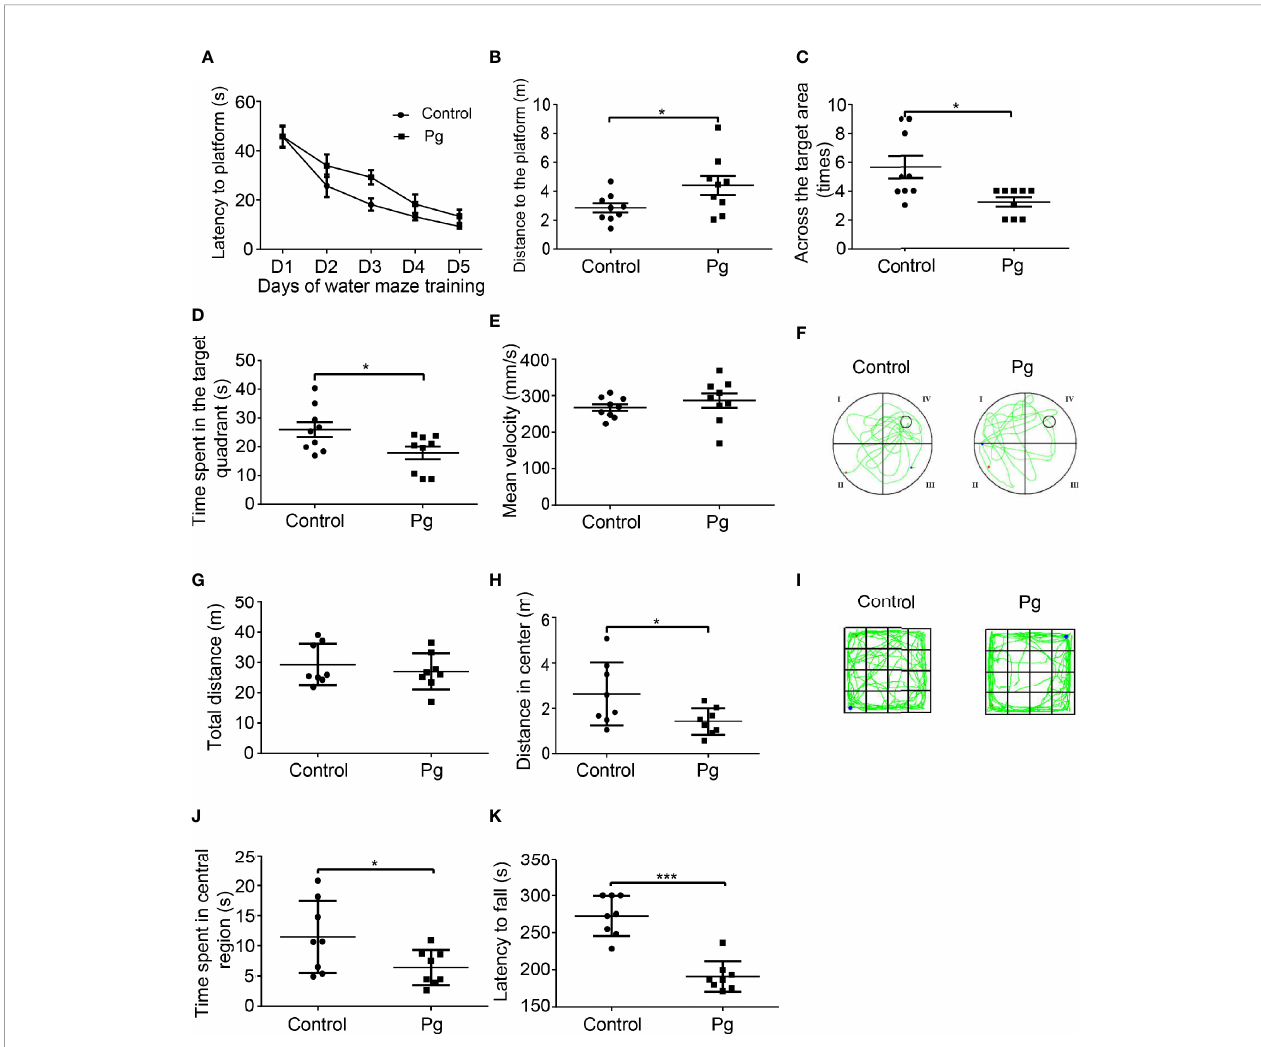
FIGURE 1 | The effects of Porphyromonas gingivalis (Pg) on behavioral changes of mice. (A) Escape latencies in spatial acquisition trial of the Morris water maze (MWM). (B) The distance of mice to locate the platform on day 5. (C) The number of times the platform was crossed in the probe trial of the MWM. (D) Target quadrant movement time in the probe trial of the MWM. (E) Mean velocity of mice in the probe trial of the MWM. (F) Representative trajectories of each group in the MWM. (G) Total moving distance in the open fi eld test (OFT); (H) distance in the central region of the OFT. (I) Representative trajectories of each group in the OFT. (J) Time spent in the central region of the OFT. (K) Latency to fall in the rotarod test. Each dot represents data from a mouse. Data were shown as means ± SEM. * p ≤ 0.05; *** p ≤